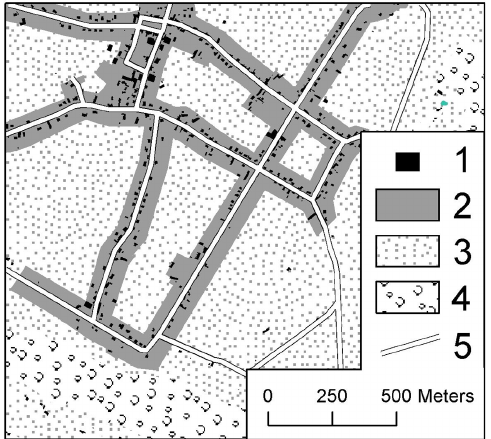
Fig. 3. Example of urban sprawl fostered by the plan de secteur in Profondeville: 1 – buildings; 2 – settlement areas of the land use allocation map (LUAM); 3 – agriculture (LUAM); 4 – forest (LUAM); 5 – roads.